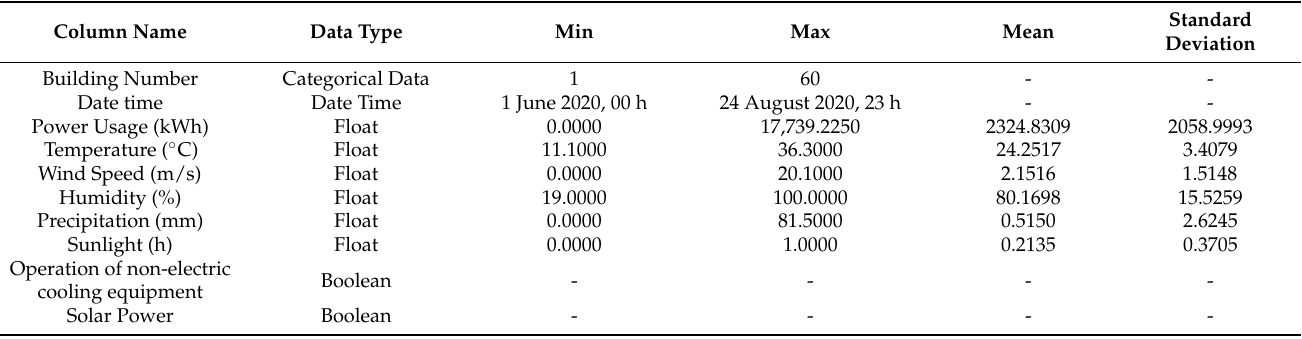
Table 1. Electric power dataset